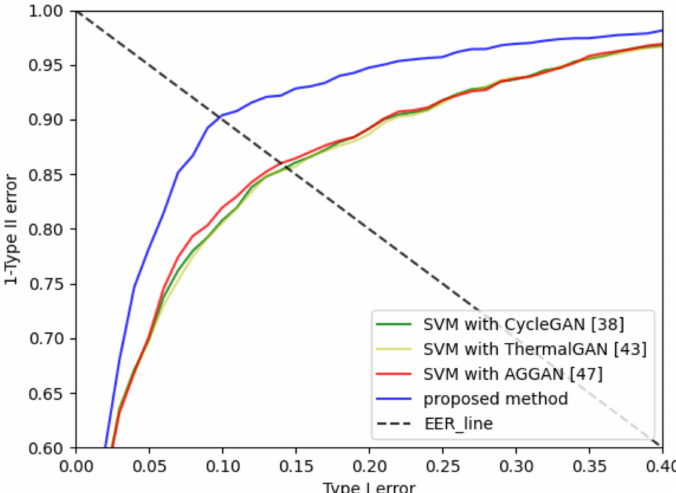
Figure 14. ROC curves of gender recognition accuracies using score-level fusion (SVM with Cycle- GAN [38] refers to Visible-light image (+IRCNN+VDSR) + syn-IR image (CycleGAN) [38], SVM with ThermalGAN [46] refers to Visible-light image (+IRCNN+VDSR) + syn-IR image (Thermal- GAN) [46], SVM with AGGAN [47] refers to Visible-light image(+IRCNN+VDSR) + syn-IR image (AGGAN)